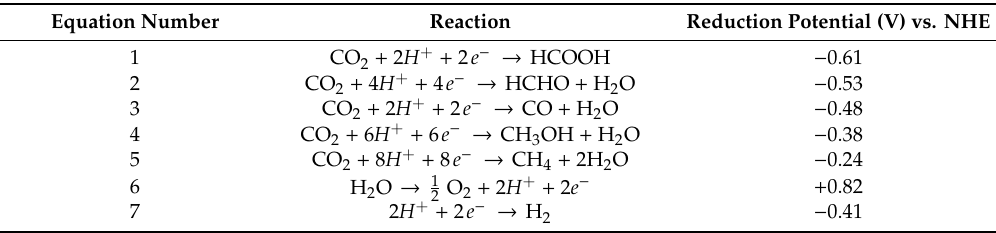
Table 1. Multielectron reactions of CO 2 reduction and their reduction potentials at pH 7.0 with reference to a normal hydrogen electrode (NHE) at 25 ◦ C and 1